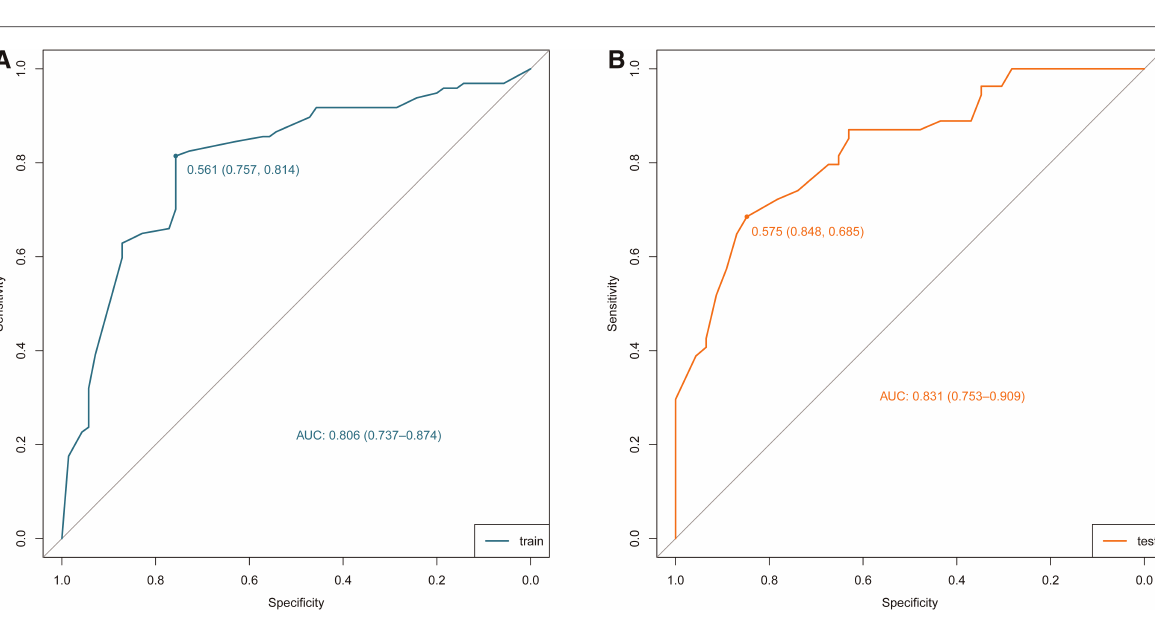
FIGURE 2 Receiver operating characteristic (ROC) curves of the nomograms in the training and validation cohorts. ( A ) Training cohort. ( B ) Validation